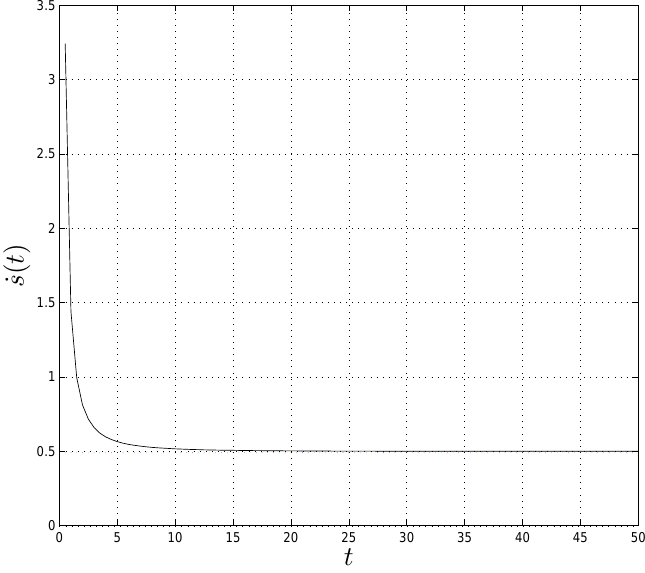
Figure 2: Numerical solution of ˙ s ( t ) versus t